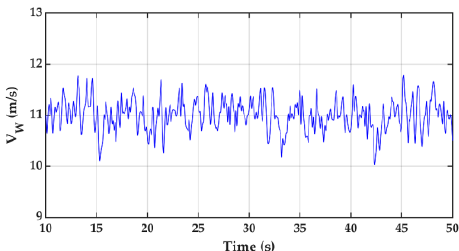
Figure 13. Fluctuation of wind speed.